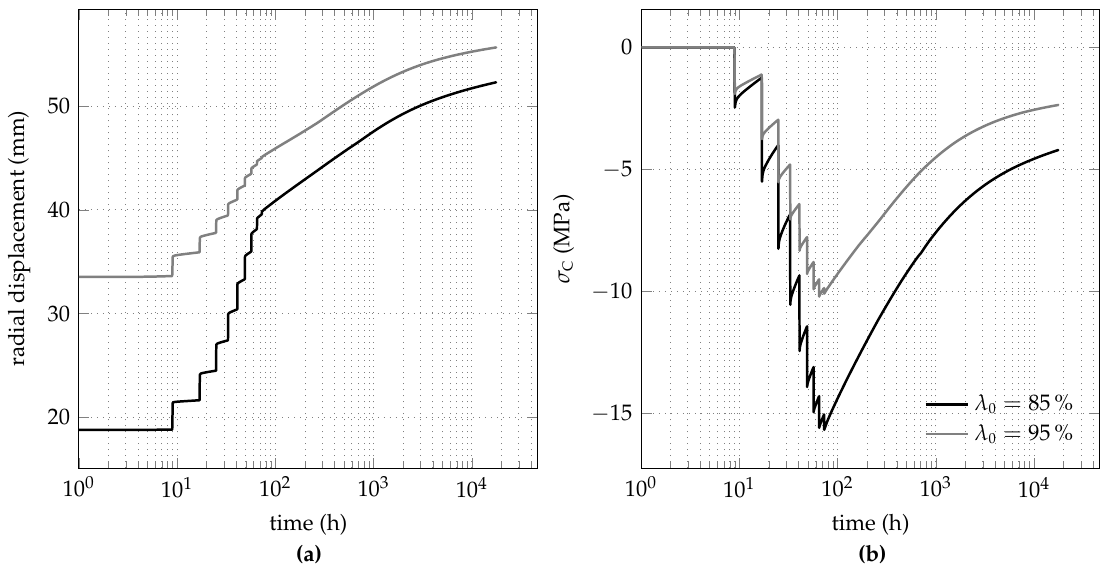
Figure 13. Long-term behavior predicted by the SCDP model for both initial stress release ratios: evolution of ( a ) the radial displacement and ( b ) the circumferential